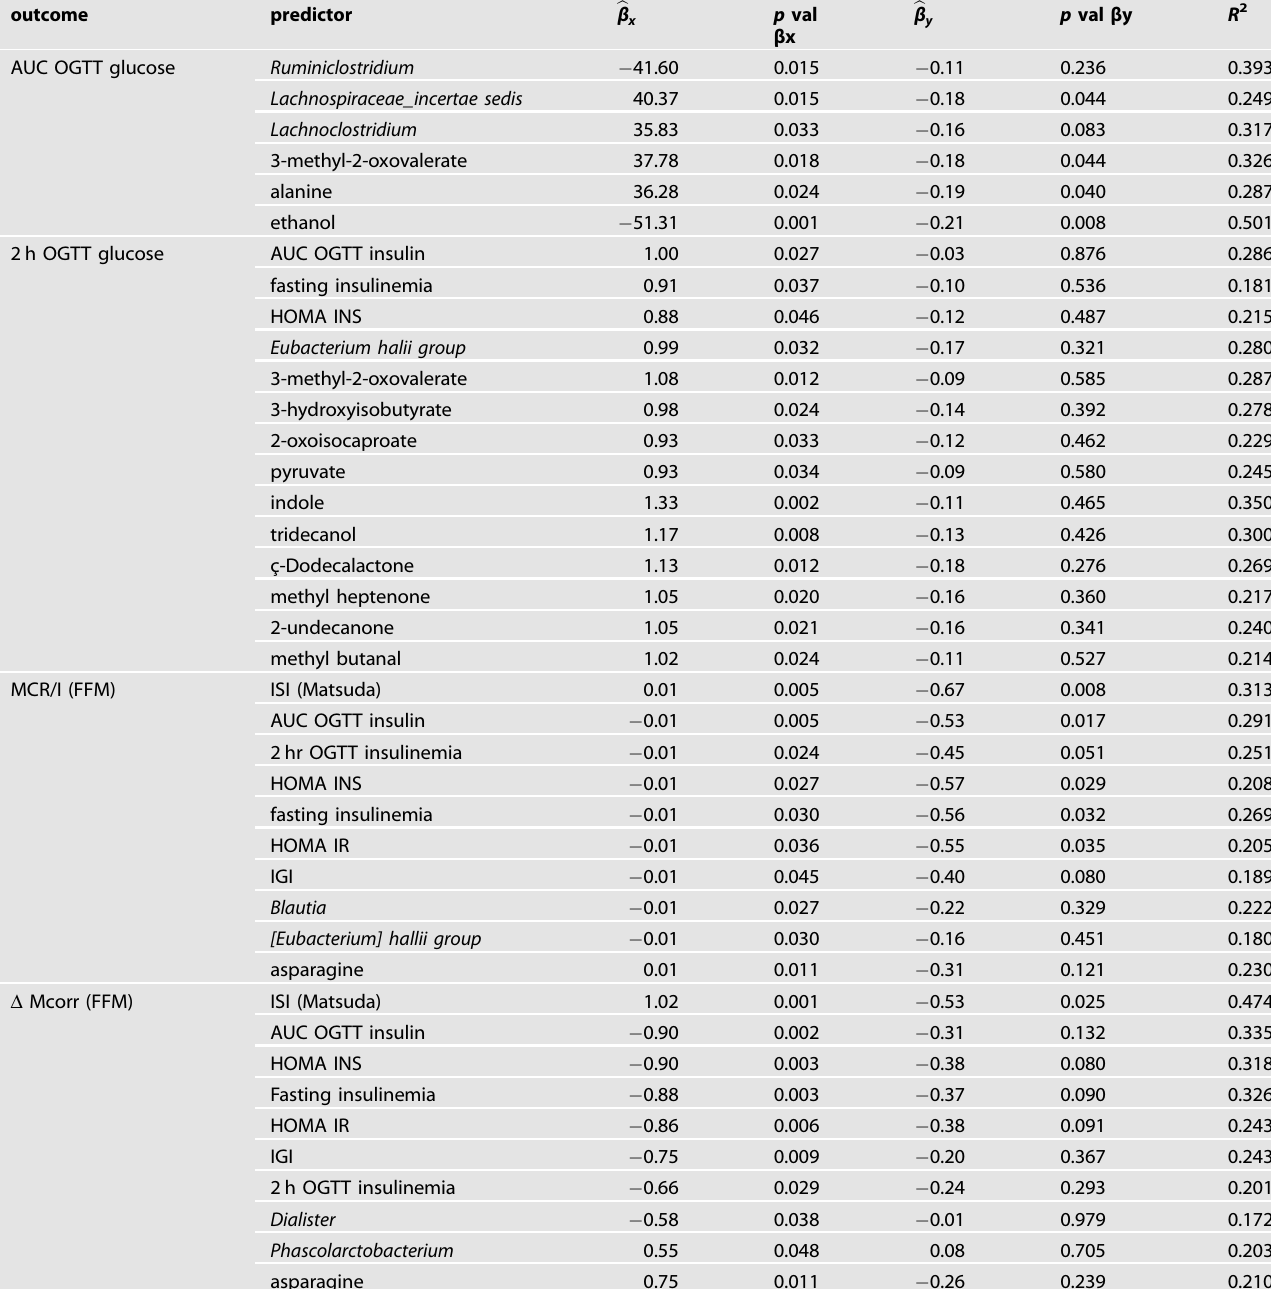
Table 2. Predictors of the inulin treatment effect on glucose homeostasis parameters.